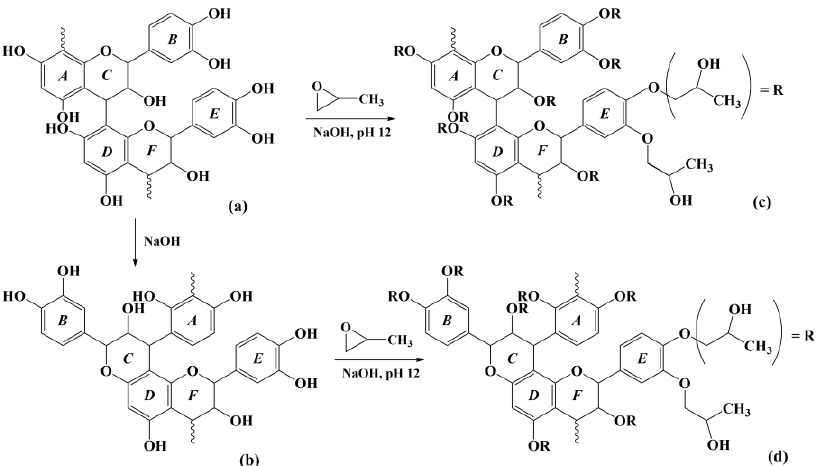
Figure 1. The structures of proanthocyanidin (PA) in pine bark ( a ), phlobaphene ( b ), and hydroxypropylated PA ( c ) and phlobaphene ( d ).